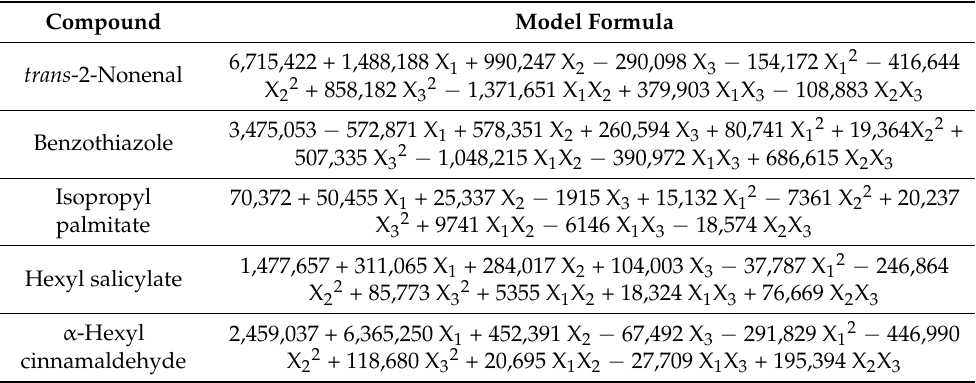
Table 2. Peak area prediction formula of each compound obtained through BBD in optimization of INME-GO:PANI/ZNRs/ZIF − 8 analysis